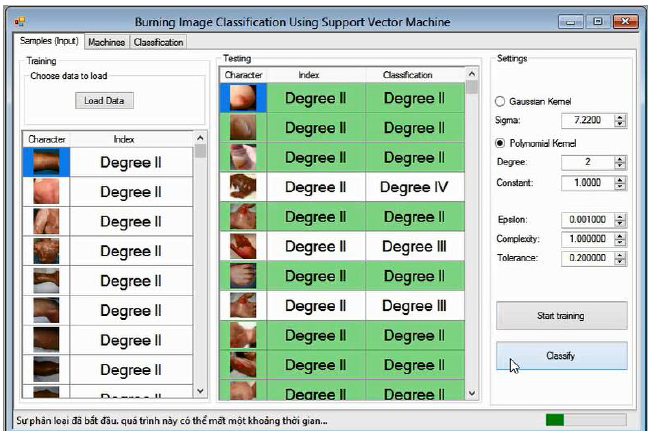
Fig. 17. Burn Image Classification User Interface